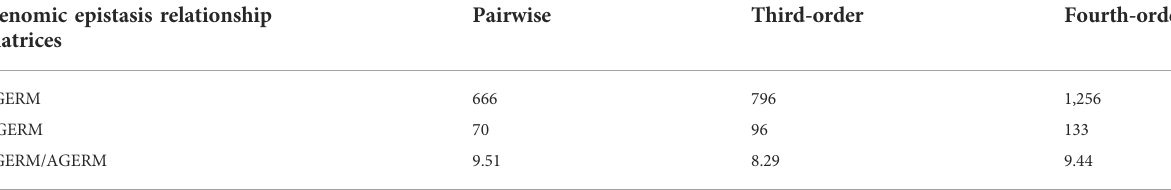
TABLE 3 Computing time (in seconds) for the construction of exact and approximate genomic epistasis relationship matrices for a swine population with 3,534 pigs and 52,843 SNPs using 20 threads of the Mangi supercomputer of the Minnesota Supercomputer Institute at the University of